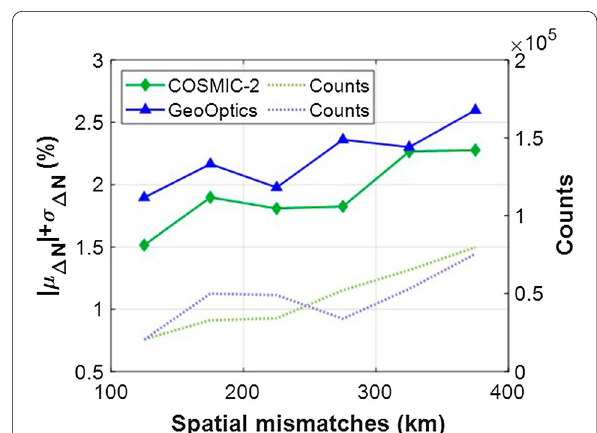
Fig. 13 Error statistics of refractivity (compared to radiosonde) with respect to spatial mismatch distances. The error statistics and counts of COSMIC-2 RO are shown as the green curve with diamonds and green dotted curve, respectively. The error statistics and counts of GeoOptics RO are shown as the blue curve with triangles and blue dotted curve,